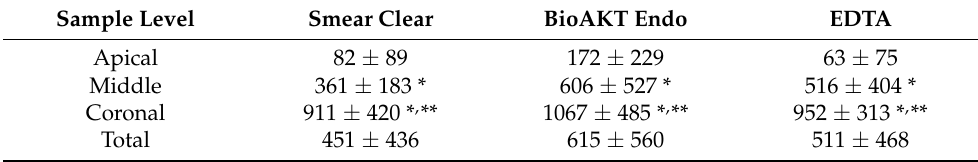
Table 3. Medium penetration of irrigants ( µ m, mean ± s.d.).